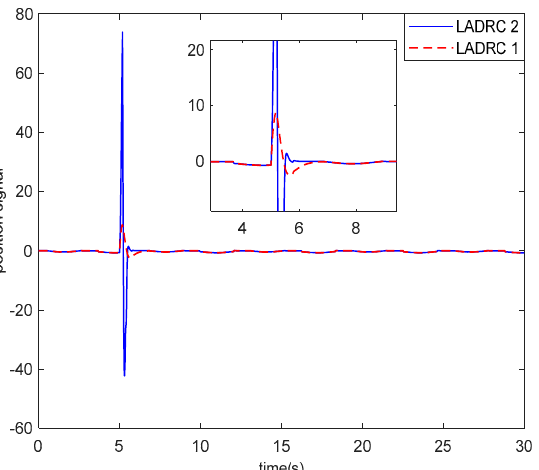
Figure 23. Comparison results of control signal between the LADRC with ATD and LADRC without ATD.